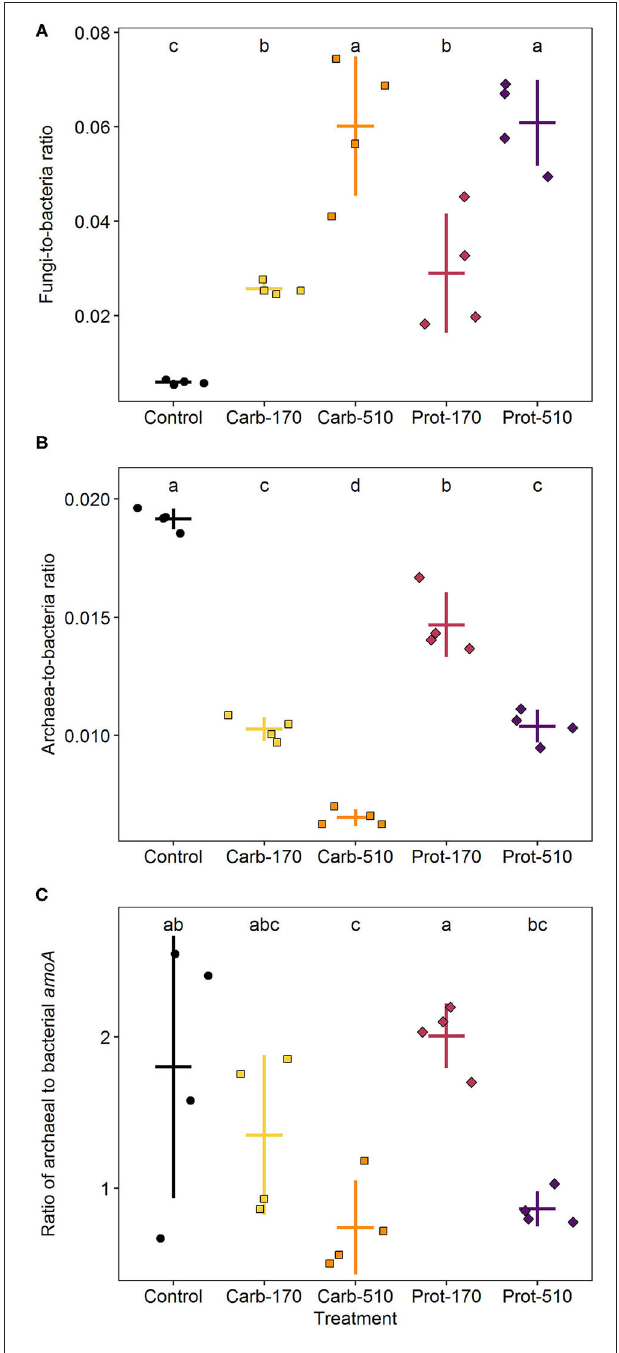
FIGURE 5 | Ratios of fungi to bacteria (A) , archaea to bacteria (B) , and archaeal to bacterial amoA gene copies (C) at the end of incubation. Means ± standard deviation ( n = 4) and letters indicating significant differences (for statistical data see Supplementary Table 2 ) are shown.